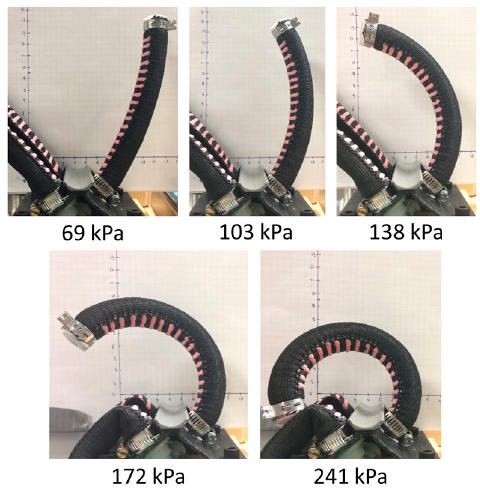
Figure 6. Sleeved bending actuator under various operating pressures (small).